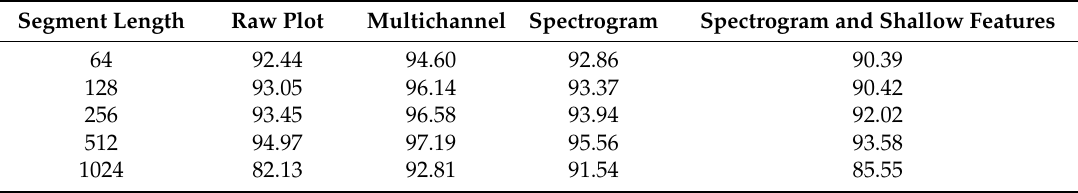
Table 2. Overall accuracy (%) of the four data transformation methods, based on five segmentation options. Segment